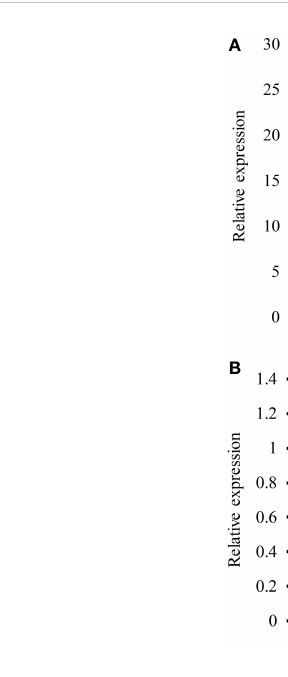
FIGURE 2 Expression level of JcHDZ21 gene in physic nut growth in control and salt stress conditions. (A) Expression levels of JcHDZ21 gene in different tissues of physic nut under normal growth conditions. (B) Expression level of JcHDZ2 1 gene in physic nut leaves treated with 150 mM NaCl. Data are from three independent biological replicates, asterisks represent signi fi cant differences (p<0.01).